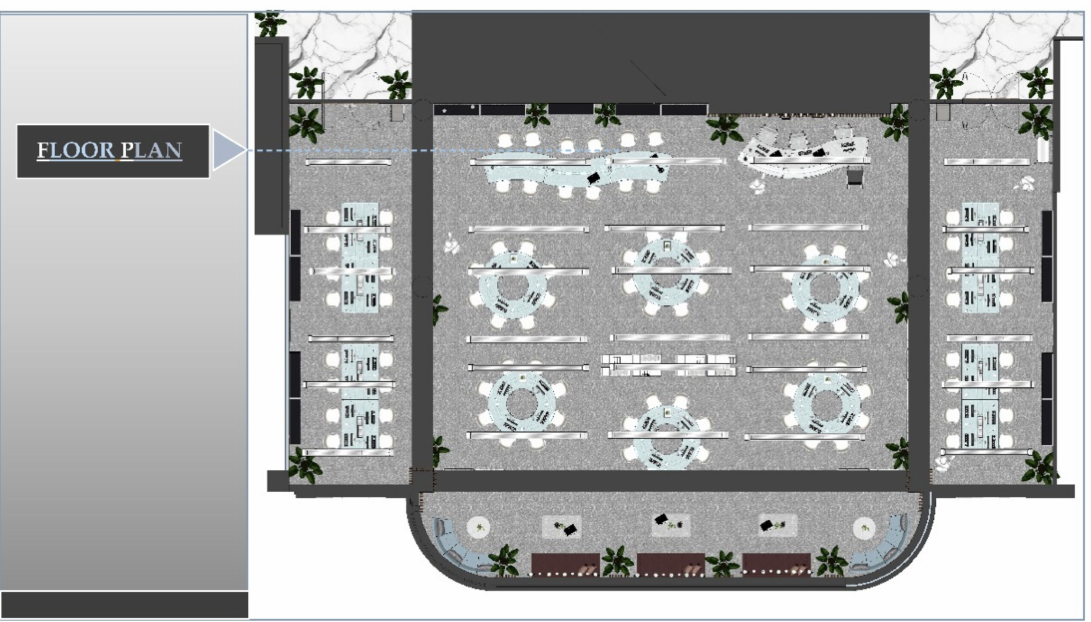
Figure 5. Floor plan of the academic library.